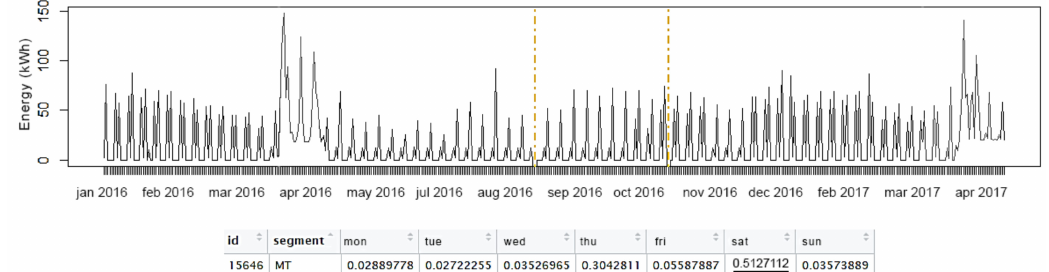
Figure 9. Example of installations labelled “Concentrated consumption (week)”.